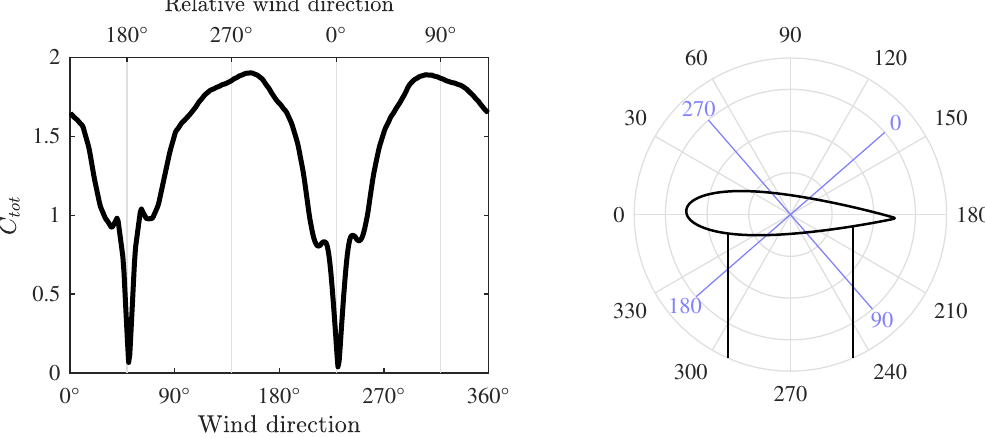
Figure 6. Left : The coefficients of the squared curve fits as a function of wind direction. The lowest value occurs at 228 ◦ during the electrical braking situation and at 233 ◦ for the mechanically-fixed situation. Right : The deviation in the data as defined by Equation (3).